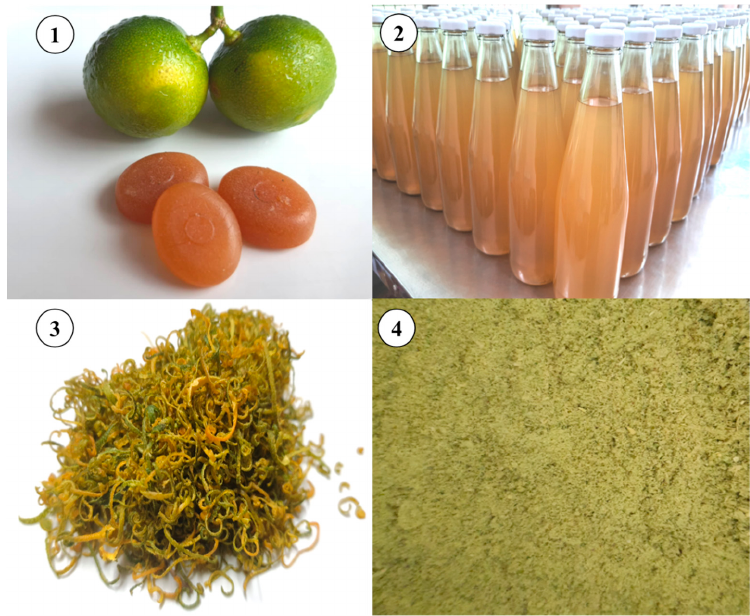
Figure 3. Calamondin and its processed products: ( 1 ) Calamondin candy, ( 2 ) Sterilized juice, ( 3 ) Dried peel, and ( 4 ) Residue powder. Table 4. Bioactive compounds of calamondin juice, peel, pulp, and seeds and their bioactivities .